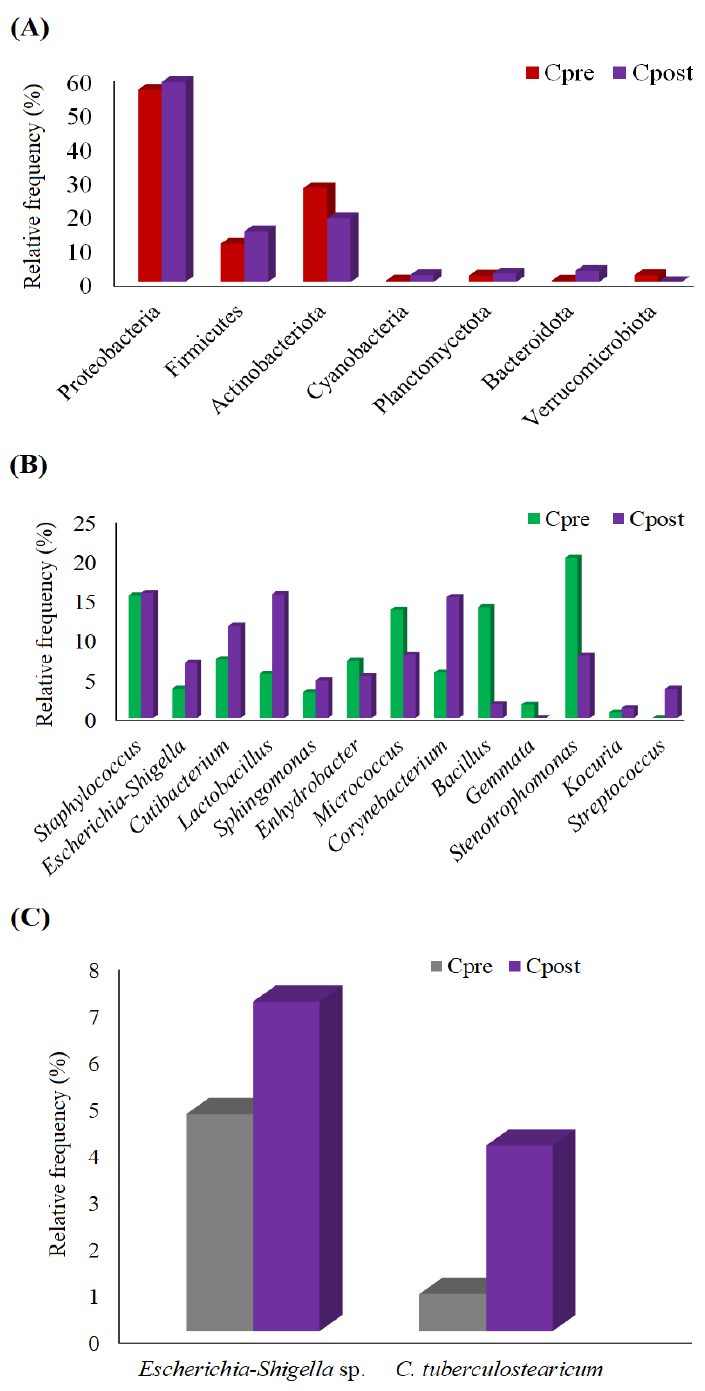
Figure 3. The graph shows the detected phylum ( A ), genus ( B ), and species ( C ) in the control group. The significant inter and intra-group differences in phylum were estimated in